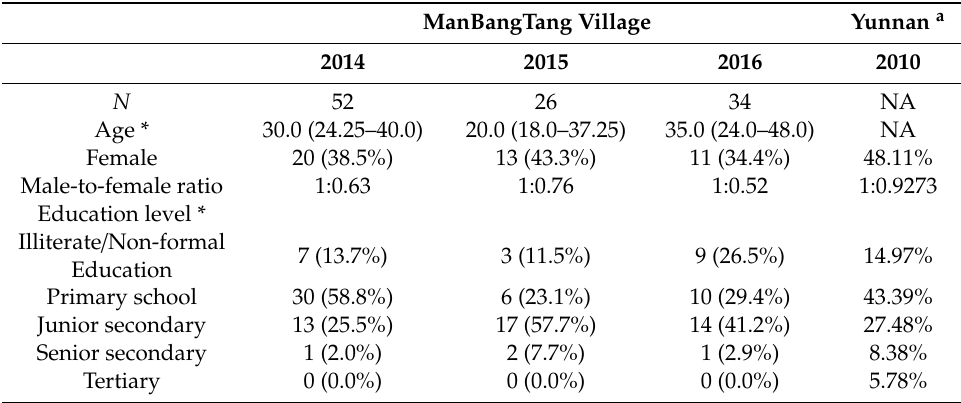
Table 2. Sociodemographic characteristics of the households participating in the 2014 to 2016 field visits in ManBangTang Village, Yunnan,